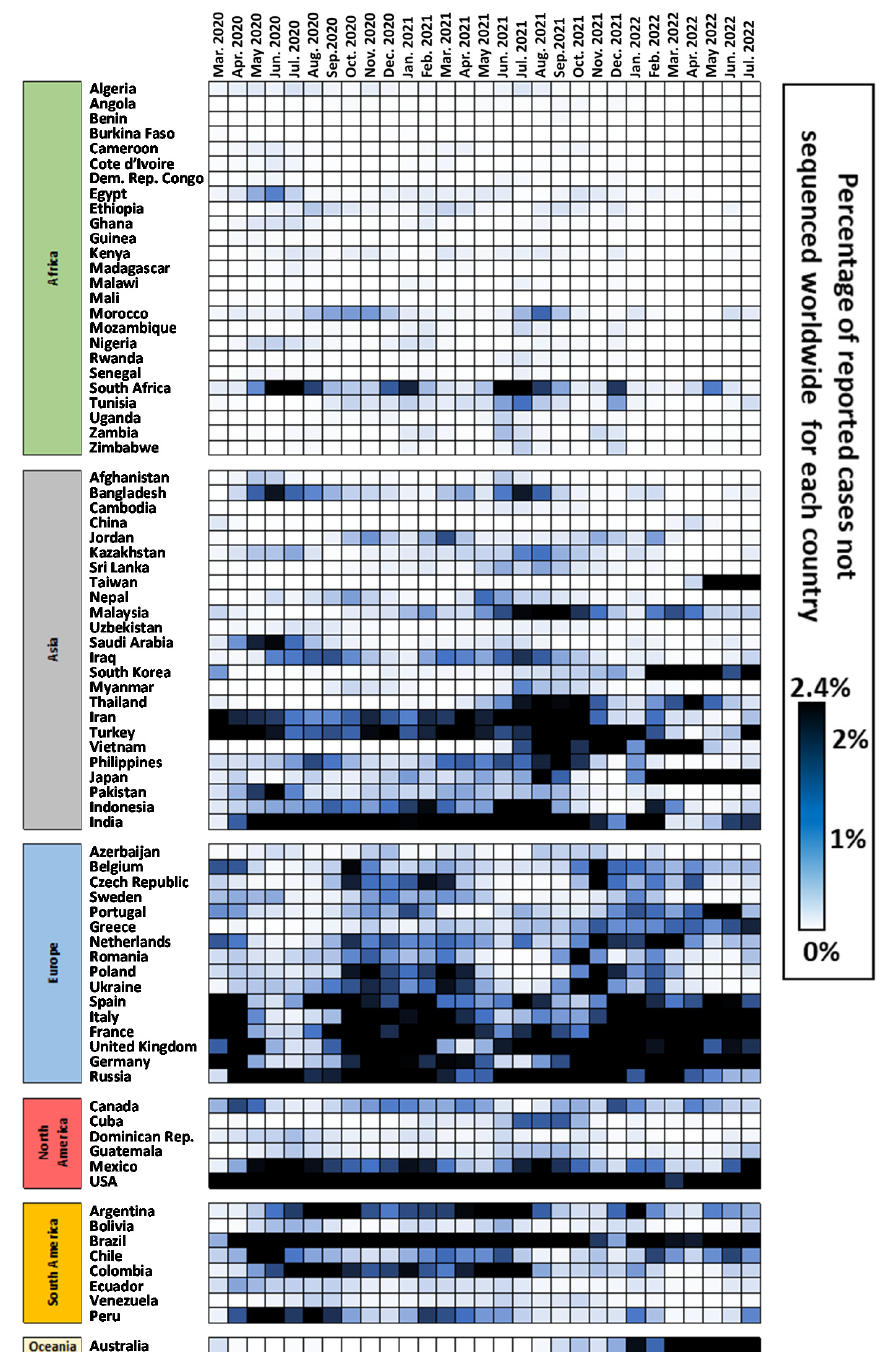
Figure 5. Heat map representing the percentage of hypothetical uncharacterized genomes present in each country against the hypothetical global values. A scale from white to blue to black indicates an increasing percentage. Black indicates that in that month, that country accounts for 2.4% or over of genetically uncharacterized SARS-CoV-2 genomes in the world.